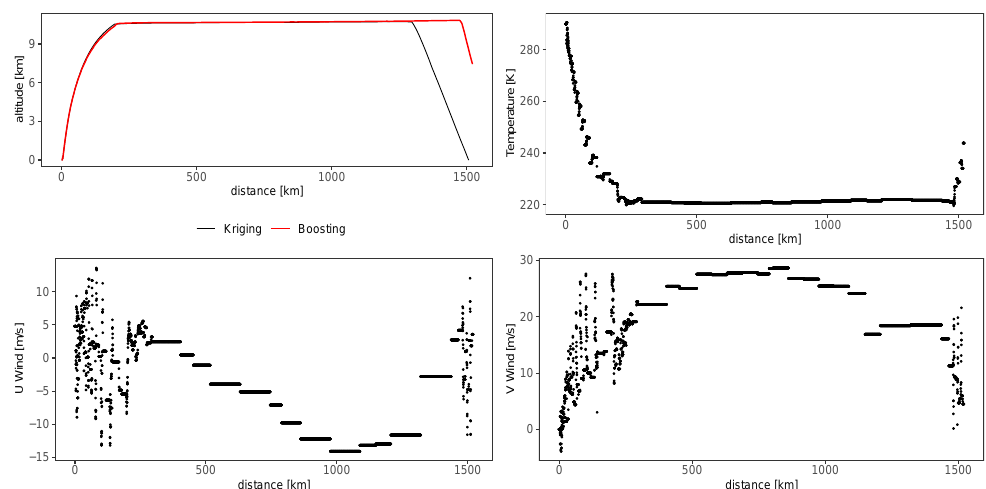
Figure 19. Trajectory generated by SOPHIA (topleft) and weather information interpolated by